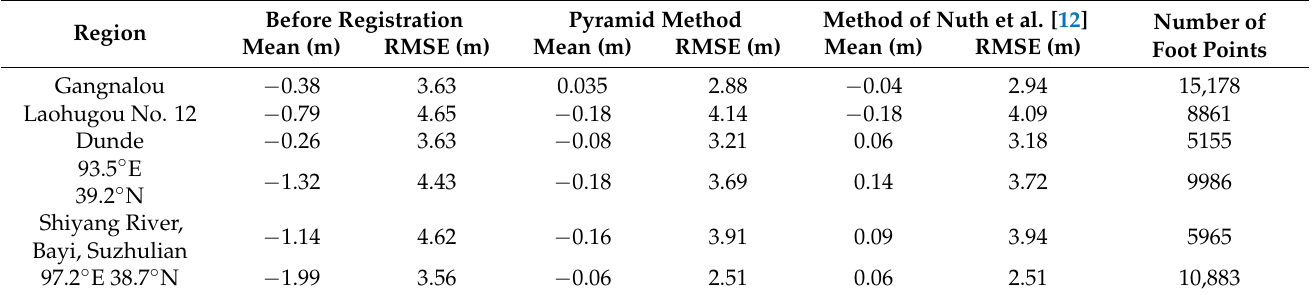
Table 1. Comparison of registration